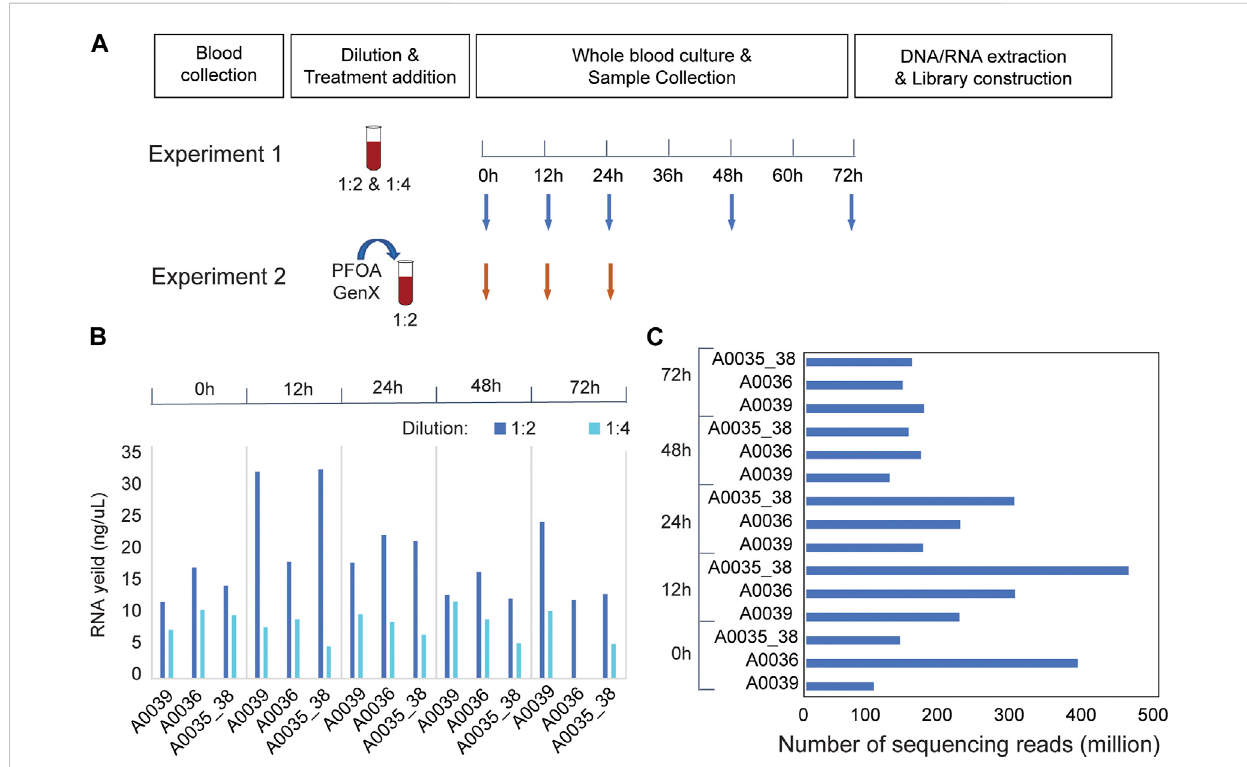
FIGURE 1 RNA-seq experiments in Monodelphis domestica whole blood culture samples without chemical disturbance. (A) Design of pilot experiments for protocol development (Experiment 1) and toxicity (Experiment 2). (B) RNA yield of Monodelphis domestica whole blood culture samples with different dilution factors and culture times. (C) RNA sequencing yield in Experiment